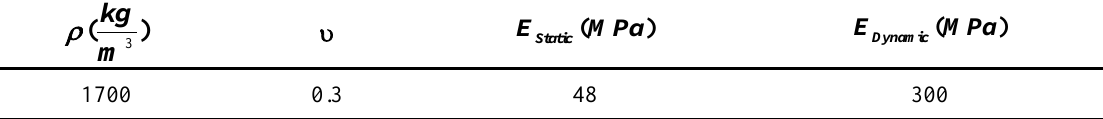
Table 1. Soil elastic parameters used for all soil types